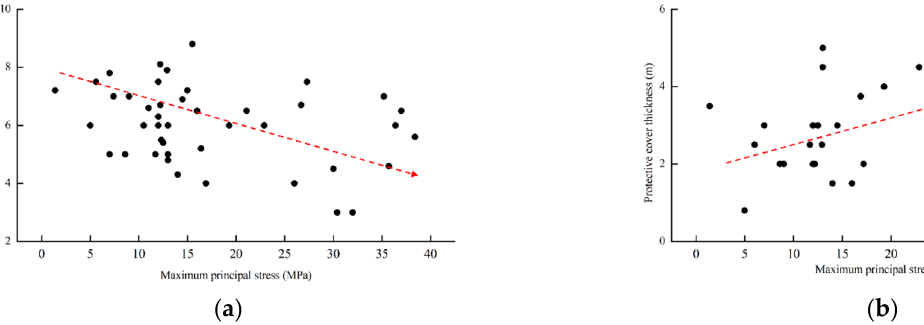
Figure 19. The relationship between key design parameters and in situ stress level at the high side wall zone. ( a ) The changing trend of stratification height. ( b ) The changing trend of protective cover thickness.